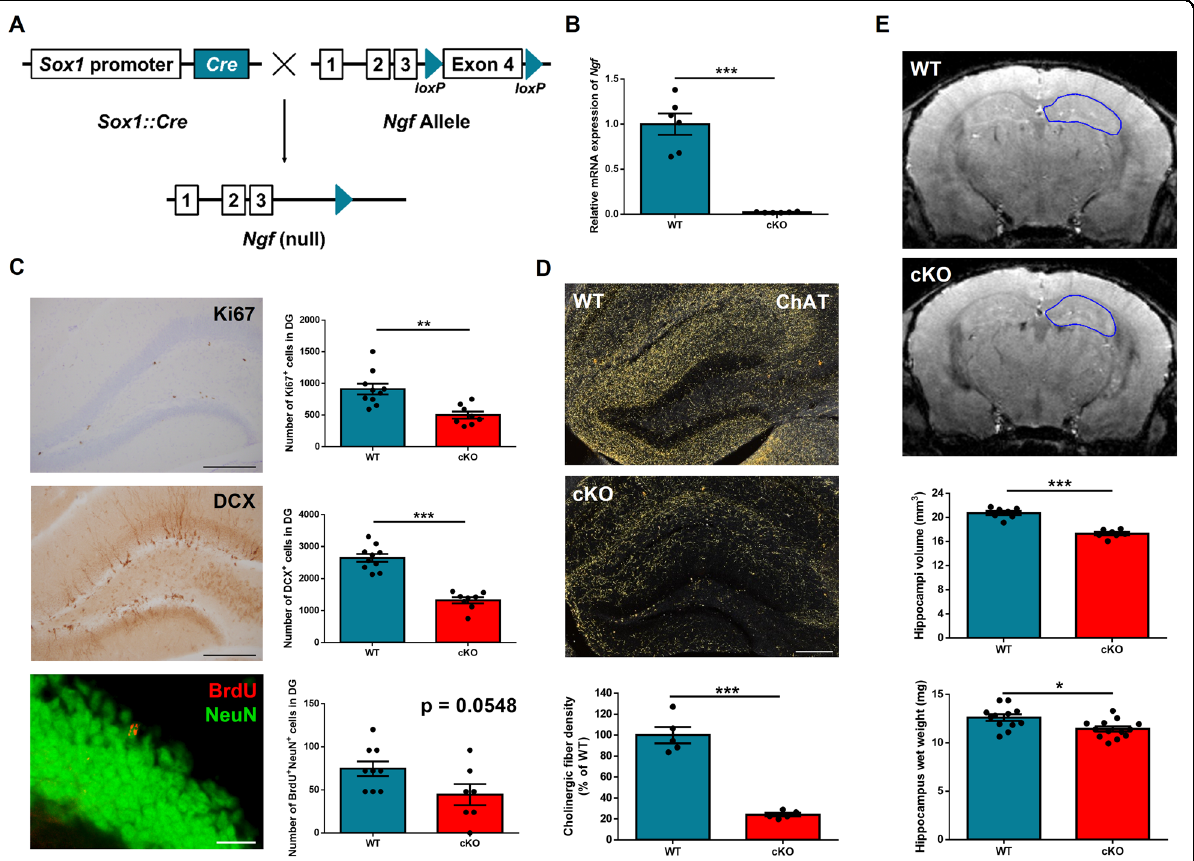
Fig. 1 Ngf -knockout mice show decreased hippocampal neurogenesis and depleted cholinergic innervations. A Ngf fl oxed mice were crossed with Sox1 :: Cre mice to knock out Ngf speci fi cally in the brain from early development. B We con fi rmed the high knockout ef fi ciency of Ngf in the hippocampus at mRNA ( n = 6). C Images of neurogenesis markers DCX, Ki67, and BrdU and cell counts in the dentate gyrus of the hippocampus. There were signi fi cantly decreased cell counts of Ki67- and DCX-positive cells in the Ngf cKO hippocampus ( n = 8 – 10). For the BrdU/NeuN-positive cell counts, Ngf cKO mice also exhibited decreased cell counts ( n = 7 – 9). D Images and quanti fi cation of ChAT in the hippocampus. Ngf cKO mice showed depleted cholinergic fi ber in the hippocampus ( n = 5). E Representative images of MRI scans and quanti fi cation of hippocampal volume ( n = 7). Ngf cKO hippocampi are smaller in volume compared to WT. Decreased hippocampal weight in Ngf cKO mice were consistent with the result from the MRI ( n = 12 – 13). Data shown as mean wet weight of bilateral